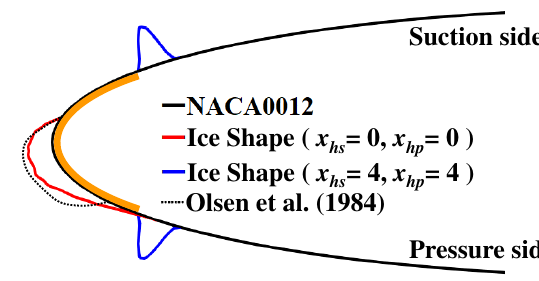
Figure 9. Formed ice shapes with and without heating. The orange bold line represents the heater location and the dot line represents Olsen’s test result [36].